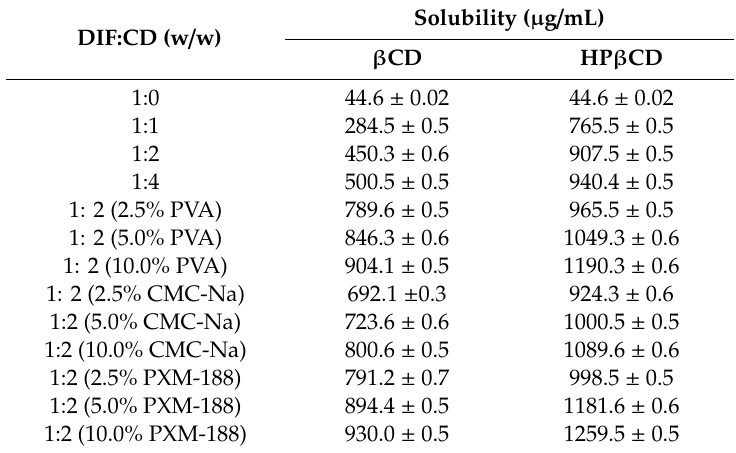
Table 2. Solubility data of DIF, binary and ternary inclusion complexes. Mean ± SD, N =